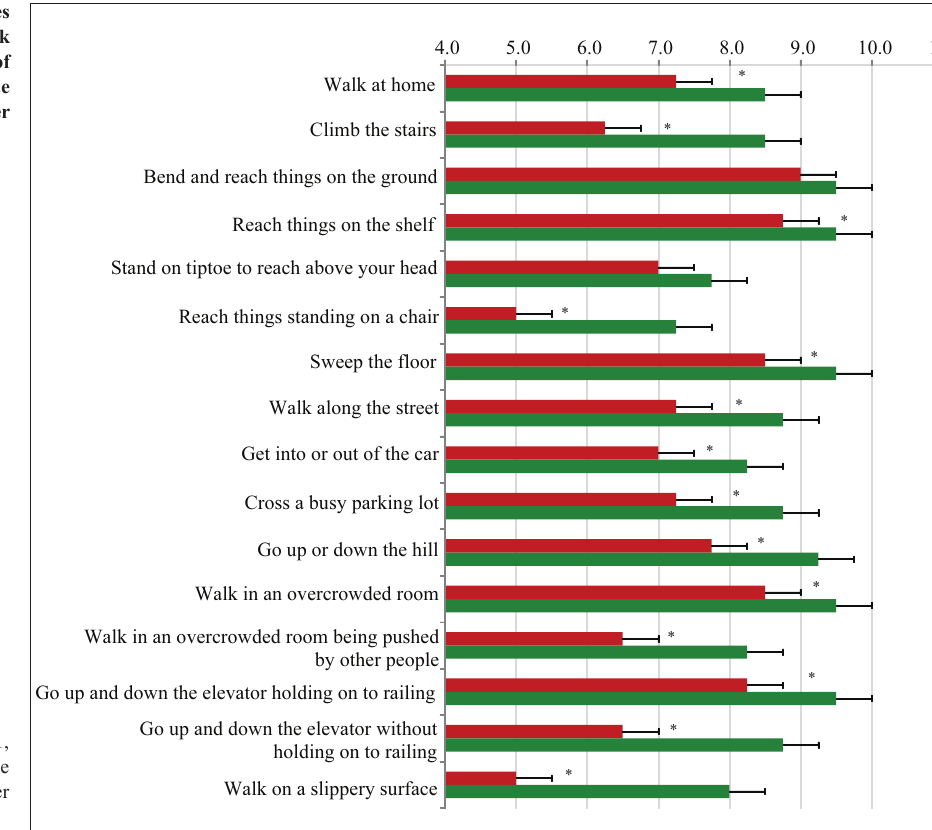
Figure 4. Averages of individual task performance results of Confidence in Balance Scale before and after